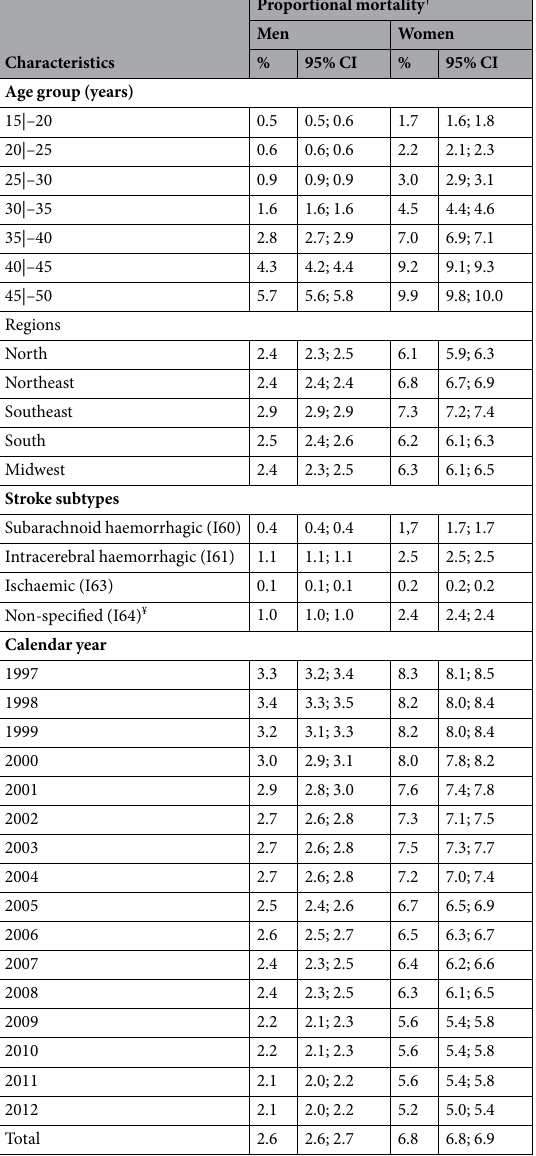
Table 2. Proportional mortality * related to stroke ** in Brazilian men and women aged 15 to 49 years between 1997 and 2012. 95% CI: 95% confidence interval. * Proportion of all deaths among individuals aged 15 to 49 years between 1997 and 2012. ** International Statistical Classification of Diseases and Related Health Problems–10th revision (ICD-10) codes: I60, I61, I63 and I64 19,20 . † In relation to the total number of deaths in people aged 15 to 49 years between 1997 and 2012, excluding ill-defined causes (R00–R99). ¥ Stroke not specified as ischaemic or haemorrhagic. Data source: Mortality Information System ( Sistema de Informação sobre Mortalidade - SIM) available from the Department of Informatics of the Brazilian National Health System